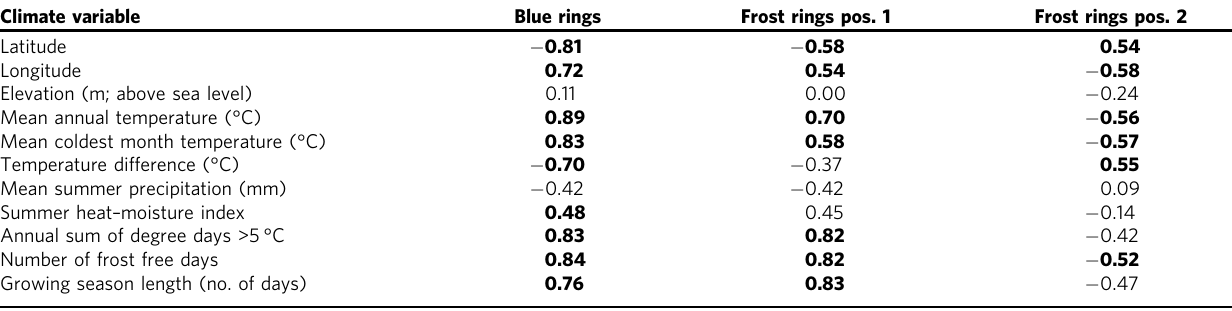
Table 2 Correlation between cold damage and climate of provenance origin Climate